Question: Express in one sentence what the figure is showing.
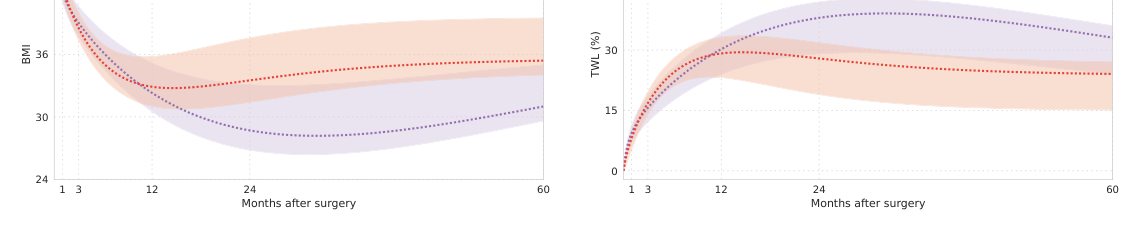
Answer: 2 – Smoothed observed median BMI (left) and total weight loss trajectories (right) with corresponding IQR for each operation, for the training cohort, testing cohorts, and the randomised controlled trial cohorts.